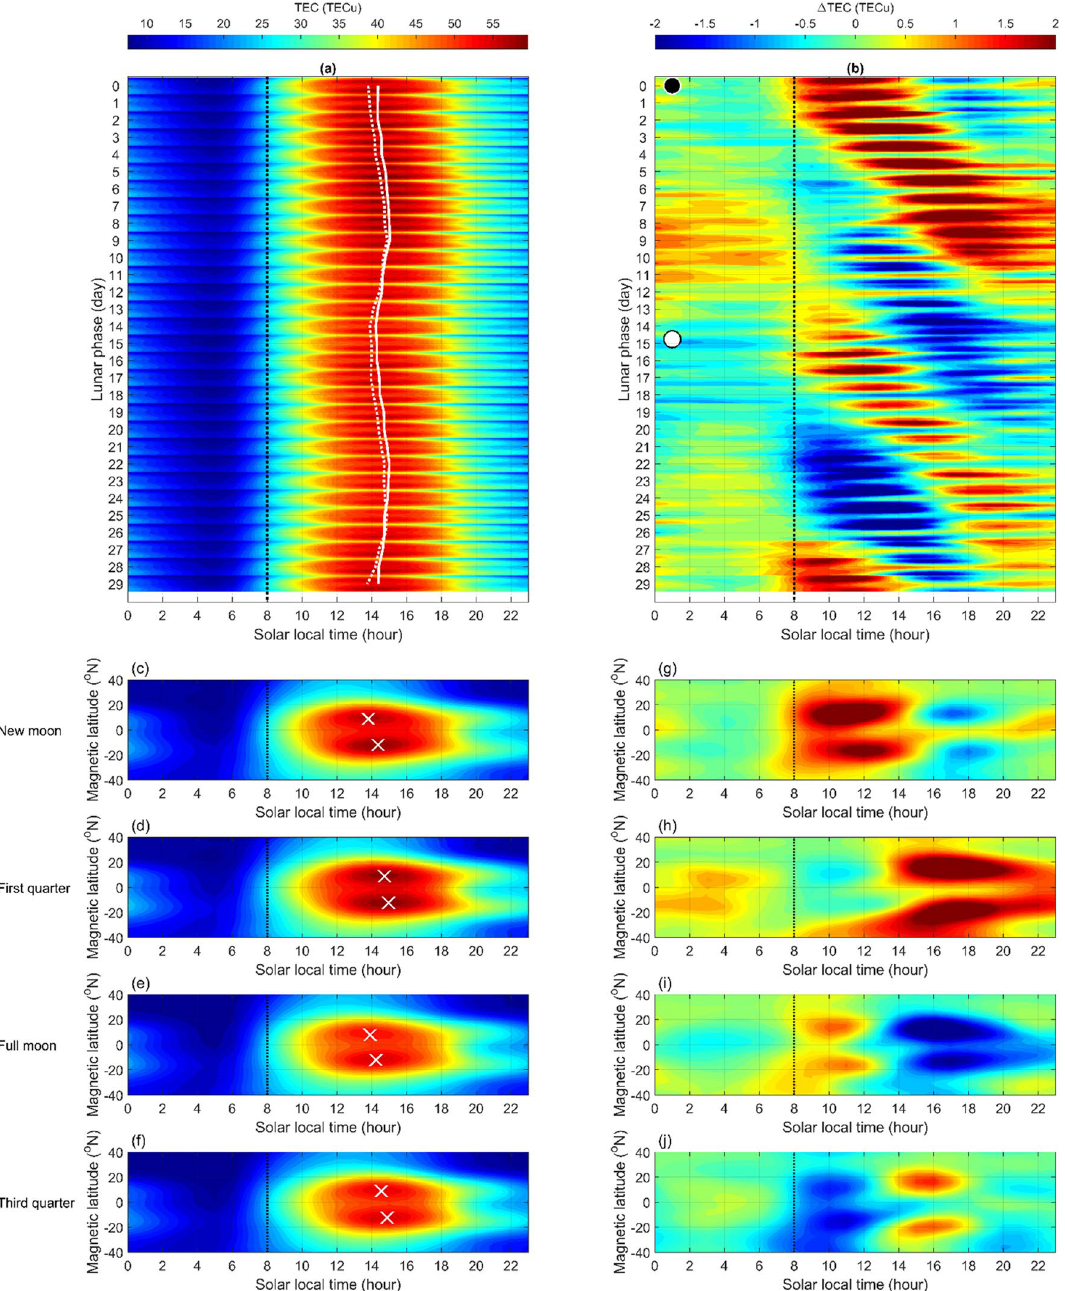
Figure 2. LTT plots of TEC and associated differences versus lunar phase during 2000–2013. ( a ) Averaged LTT plots in various lunar phases and ( b ) their departures from the overall means within ± 20° magnetic latitude during November–March in 2000–2013. ( c – f ) Averaged LTT plots on new moon (day 0), first quarter (day 7), full moon (day 14), and third quarter (day 22) ( g – j ) as well as their departures accordingly. Solid and dotted white curves denote the EIA crest appearance time in Northern and Southern Hemispheres, respectively. White cross symbols denote the corresponding EIA crests in Northern and Southern Hemispheres. Dashed black lines denote 08:00